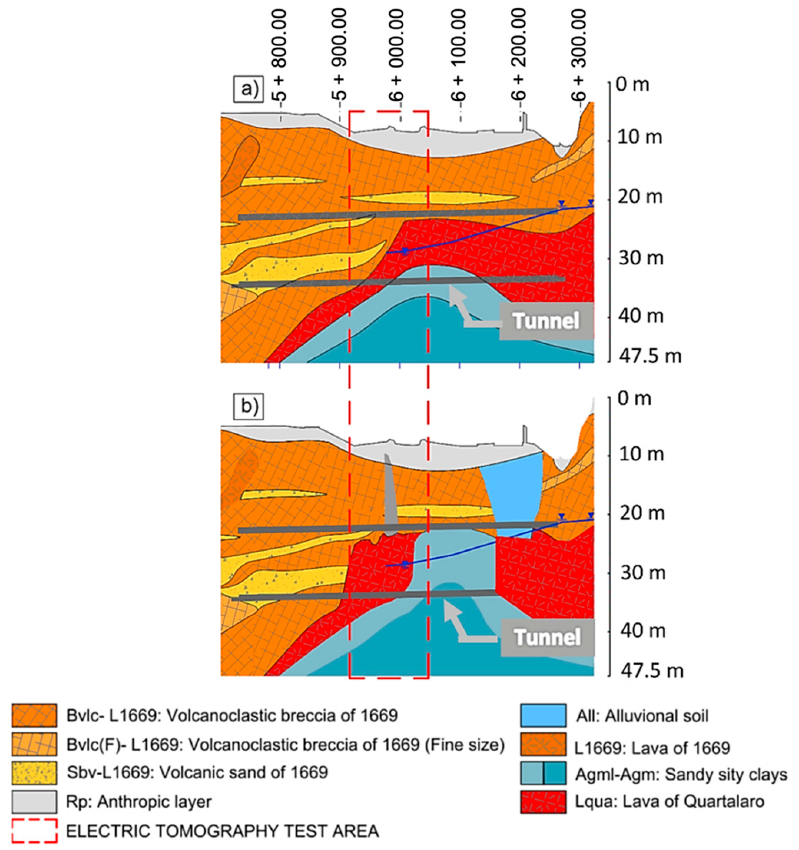
Figure 13. Zoom of the soil profile: ( a ) established during the design phase (see Figure 12c); ( b ) updated during tunnelling (see Figure 12d).